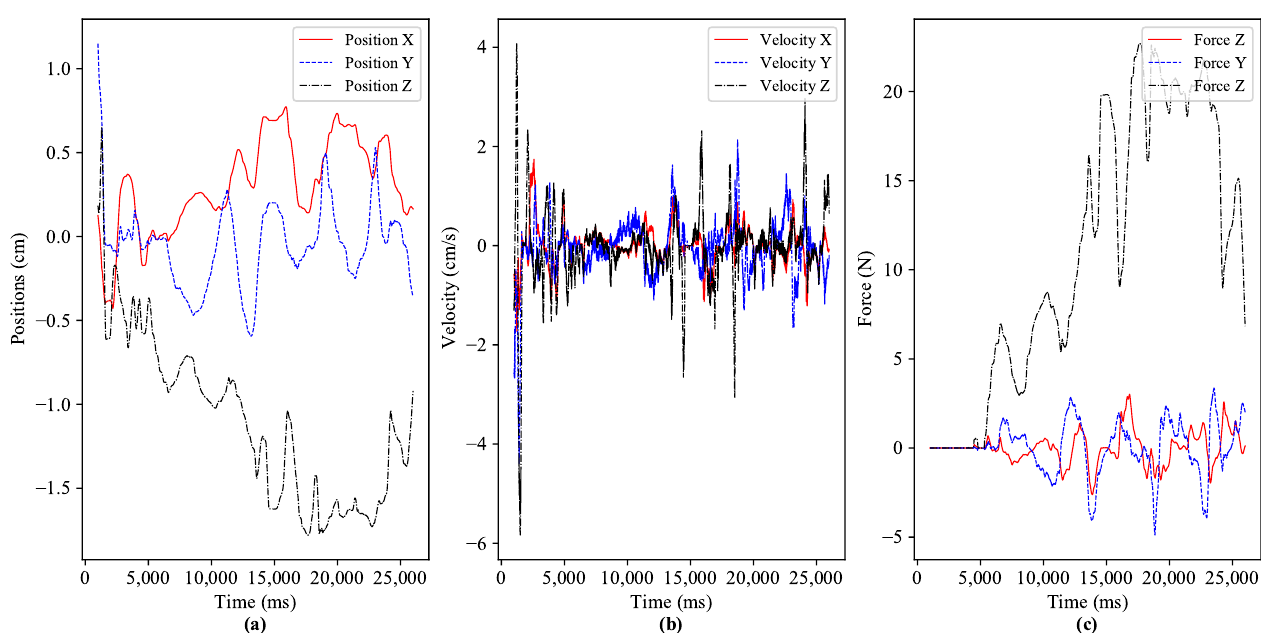
Figure 7. Dynamic interaction of the human operator with virtual application via haptic device. ( a ) positions of the human operator’s hand at master side device, ( b ) velocity traces of the operator ( c ) force data traces of the teleopertor x, y and